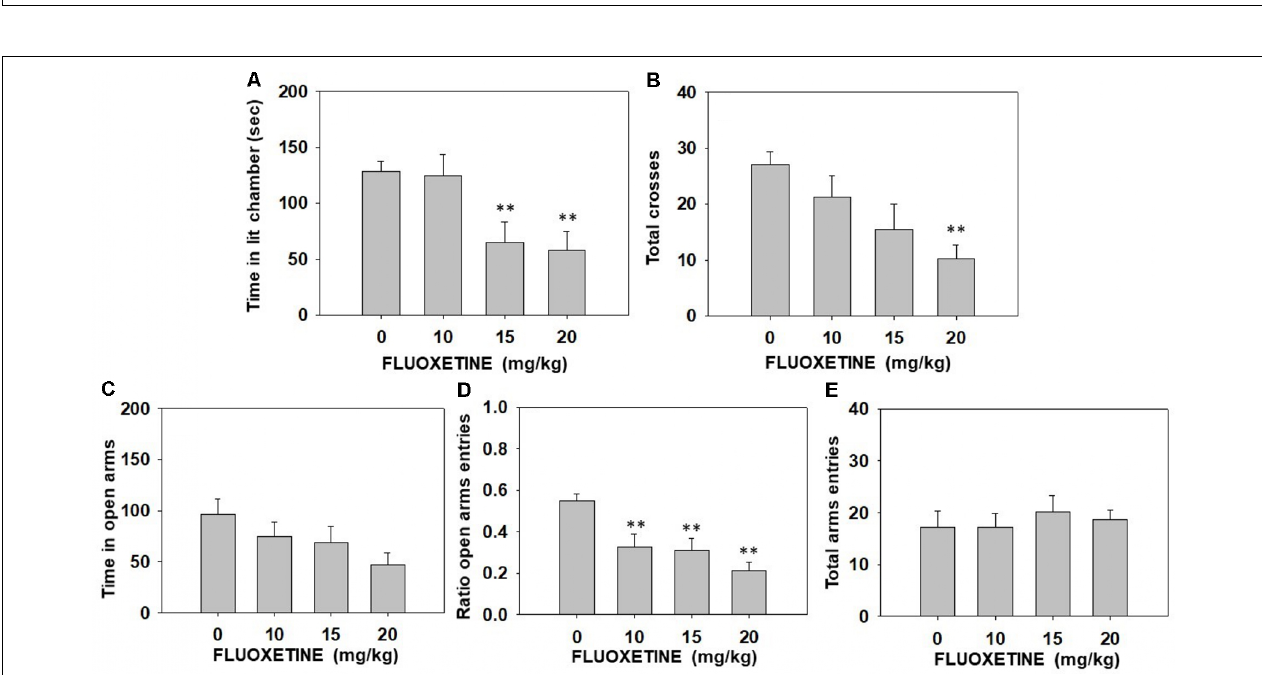
FIGURE 2 | Effect of fluoxetine (Vehicle, 10, 15 or 20 mg/kg) on time spent in the lit chamber (A) and the total of entries between the two compartments (B) of the DL box, and on time spent in the open arms (C) , ratio to the open arms (D) , and the total of entries to the four arms (E) of the EPM during 5 min each test. Groups were analyzed using one-way ANOVA for independent samples in each dependent variable. Bars represent mean ± SEM of accumulated seconds. ∗∗ p < 0.01 significantly different from the vehicle group. Abbreviations: DL box, dark and light box; EPM, elevated plus